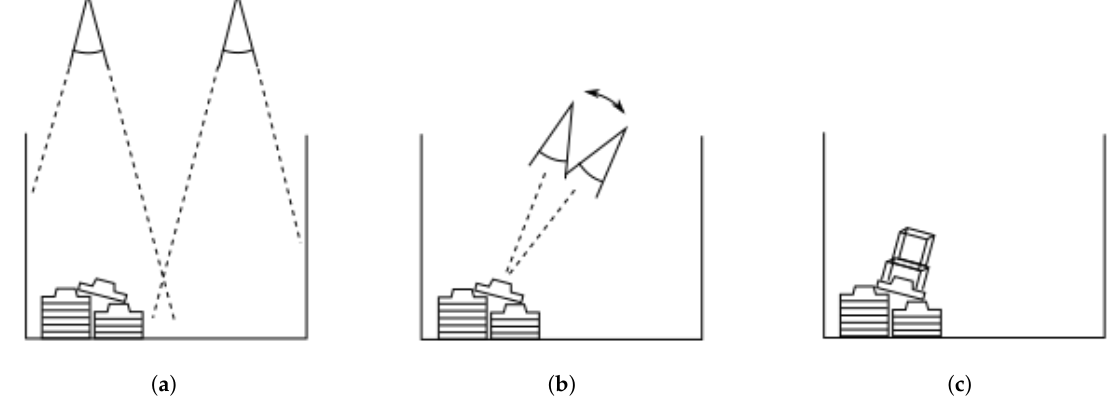
Figure 3. Control algorithm phases. ( a ) Selection. ( b ) Iterative alignment. ( c )